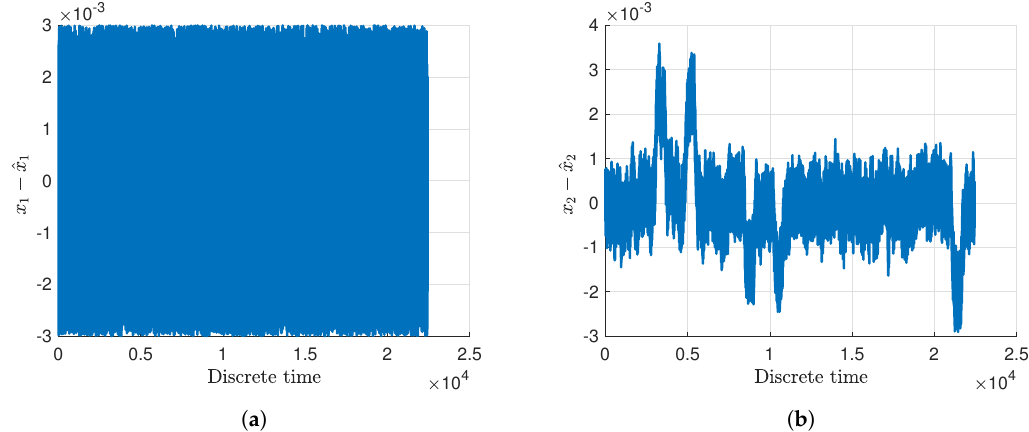
Figure 6. Evolution of the state estimation error for the U 1 ( a ) and U 2 ( b ).